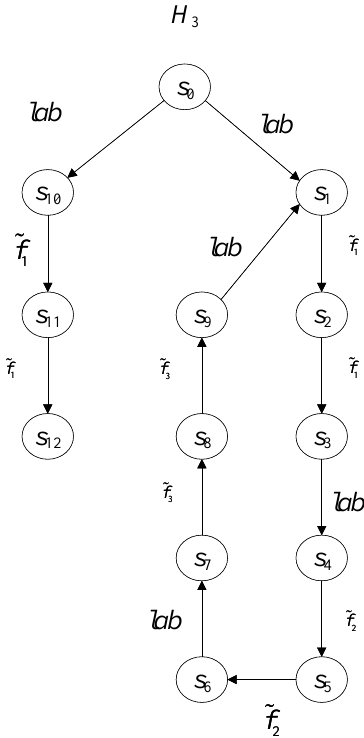
Figure 9. Approximate ILAHS.